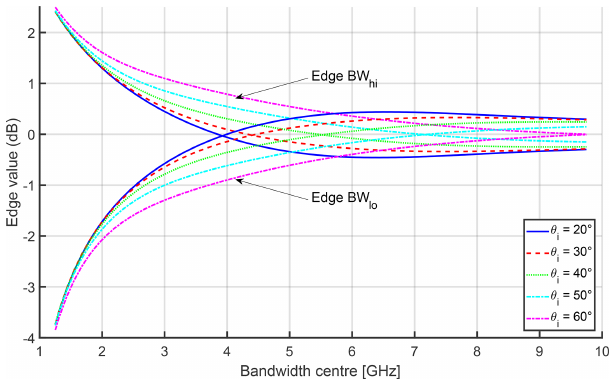
per BW calculated with the com- Figure C1. Variation of σ 0 hh bined I 2 EM (Fung et al., 2002) and Dobson (Dobson et al., 1985) model. The horizontal axis shows centre frequency of bandwidth BW = 0 . 5GHz. Curves indicate the values (in dB) to be added to (cid:104) σ 0 (BW) (cid:105) at the BW edges for different θ angles. Shown calcu- hh lation uses: s = 1cm, (cid:96) = 10cm, m v = 0 . 25m 3 m − 3 , and T soil = 15 ◦